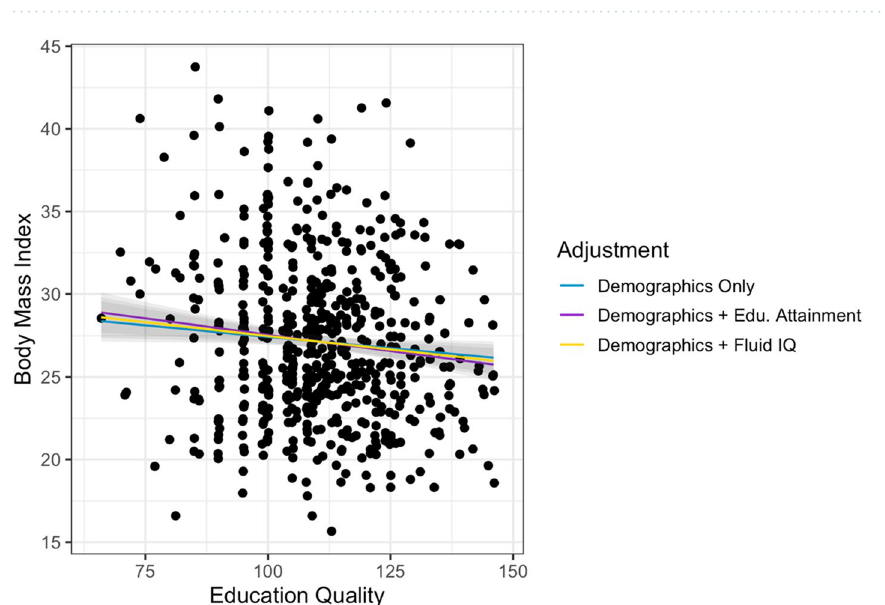
Figure 2. Associations between educational quality and BMI in the HCP-A data set. The blue line is the association between educational quality and the outcome adjusting for demographics (age, sex, ethnoracial category). The purple line further adjusts for educational attainment as measured by educational attainment. The yellow line further adjusts for fluid IQ. The strength of the association between educational quality and outcomes is virtually unchanged after adjustment for demographics, educational attainment, or fluid